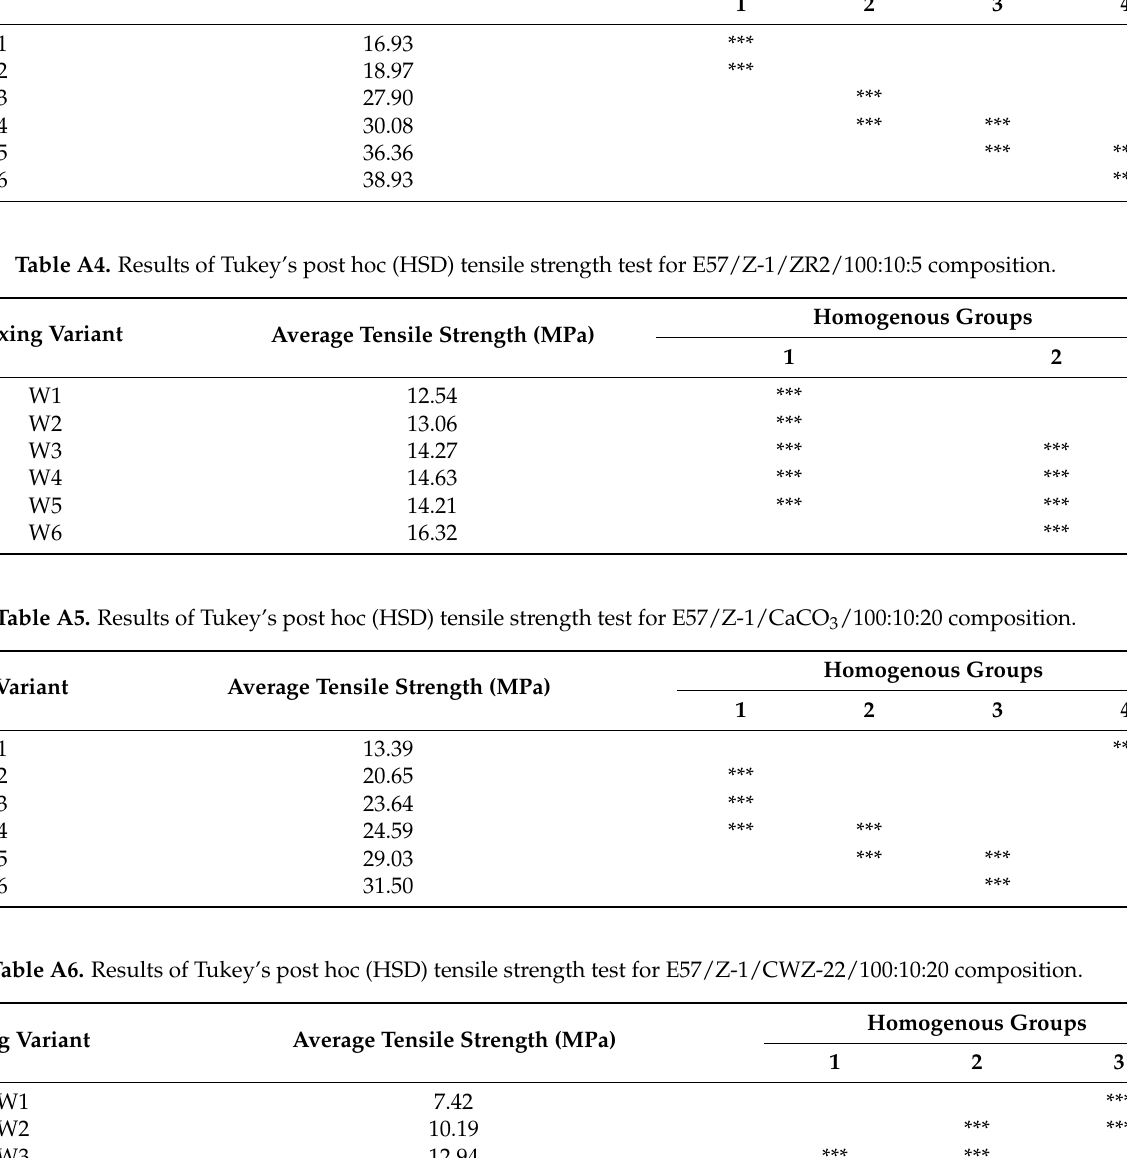
Table A3. Results of Tukey’s post hoc (HSD) tensile strength test for E57/Z-1/100:10 composition. Mixing Variant